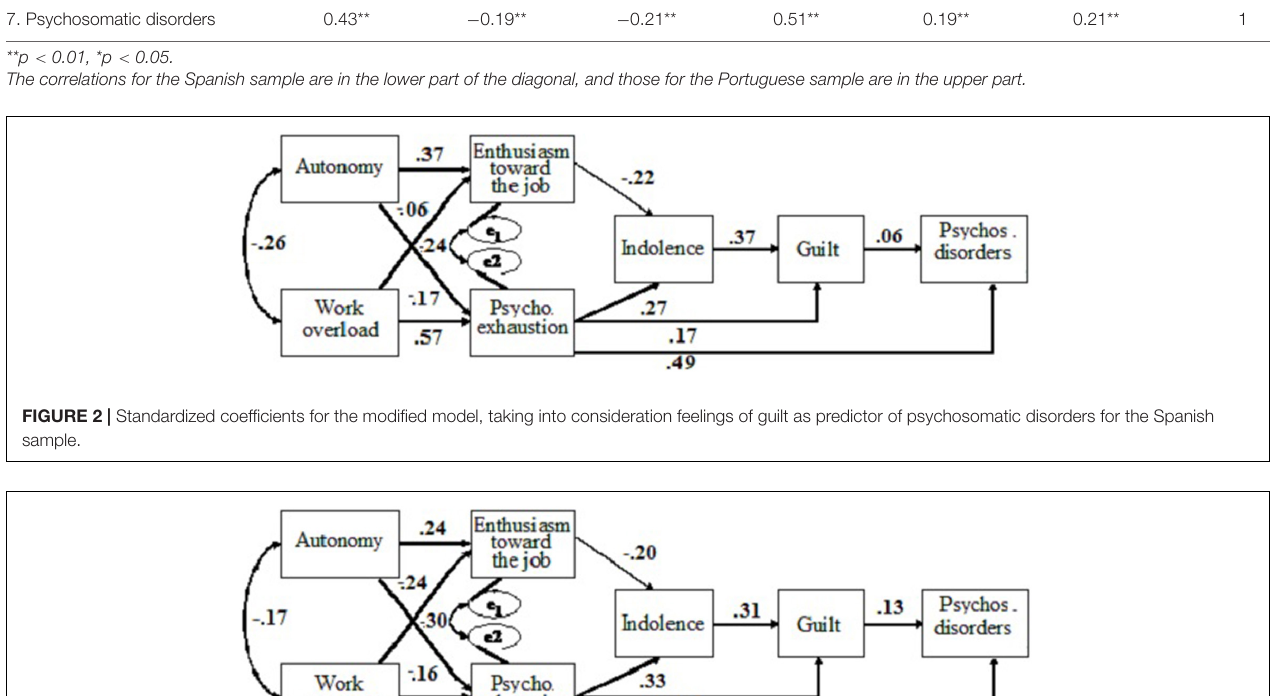
a difference of χ 2 ( 7 ) = 13.642, p > 0.05. The model was invariant regardless of the origin of the sample (Spanish vs.